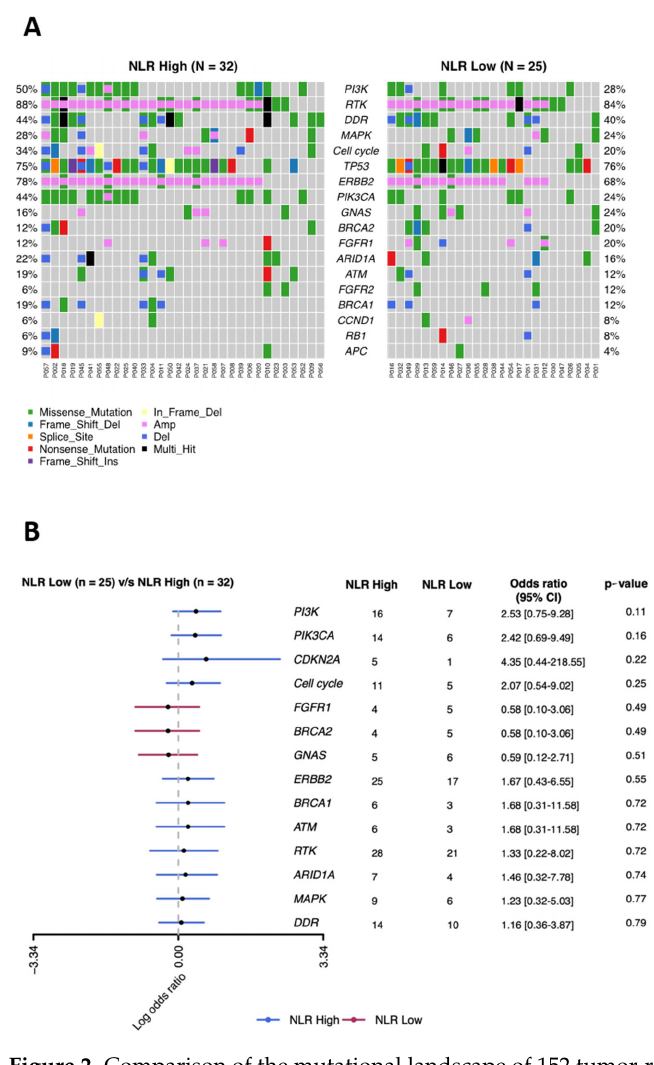
Figure 2. Comparison of the mutational landscape of 152 tumor-related genes in MBC patients with low and high baseline NLR. ( A ) Distribution of single nucleotide variants and copy number variants in the indicated genes with mutation rates of genes ≥ 5%. ( B ) Relative enrichment of key genes in the NLR ‐ high versus the NLR ‐ low group.